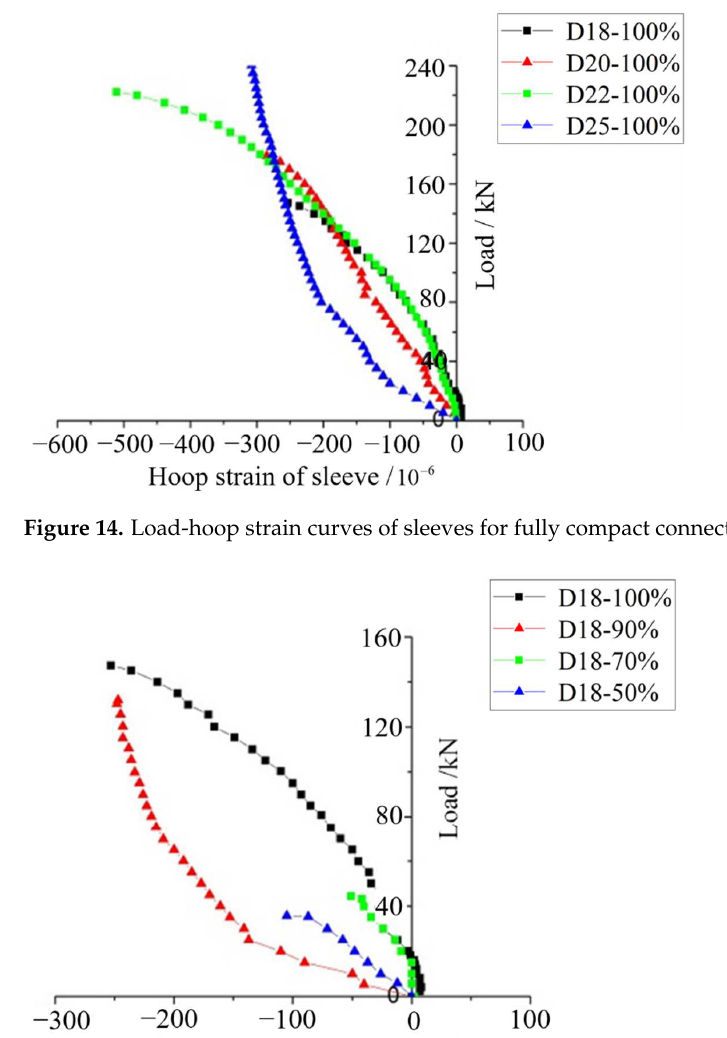
Figure 13. Longitudinal stress-strain curves of sleeve for D18 connectors with different compactness.